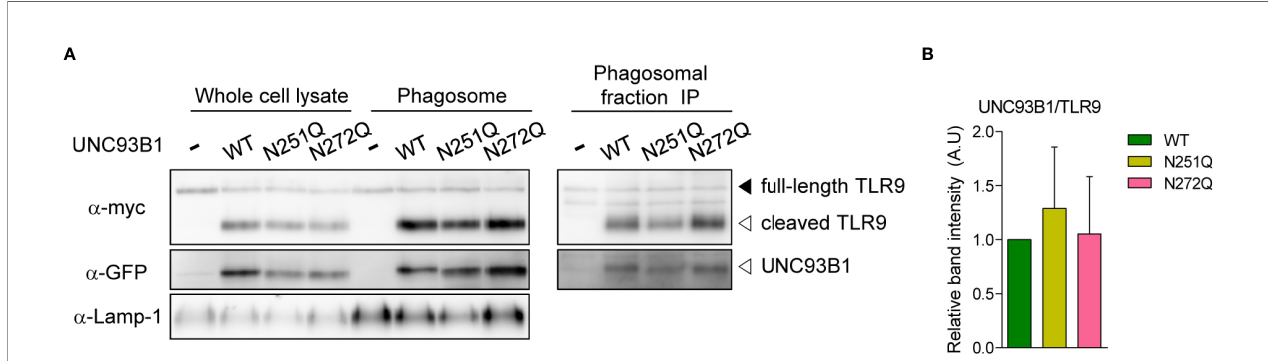
FIGURE 7 | Association between UNC93B1 and TLR9 in phagosomes is unaffected by N-glycosylation of UNC93B1. (A) Phagosomes were isolated from UNC93B1 KO iBMDMs expressing TLR9-myc and UNC93B1-GFP (wild type or mutant). TLR9, UNC93B1, and Lamp-1 in whole cell lysates and isolated phagosomes were detected by immunoblotting with anti-myc, anti-GFP, and anti-LAMP-1 antibody, respectively (left panels). TLR9 was immunoprecipitated with anti-myc antibody from the isolated phagosomes and TLR9 and UNC93B1 in the immunoprecipitates were probed by anti-myc and anti-GFP antibody, respectively (right panels). (B) The ratio of TLR9-associated UNC93B1 was calculated by dividing the band intensity of UNC93B1-GFP with that of TLR9-myc in the immunoprecipitates of phagosomes. The relative levels of the UNC93B1/TLR9 ratio among samples were presented compared to that of UNC93B1(WT)/TLR9. Data are means ± SD of two independent